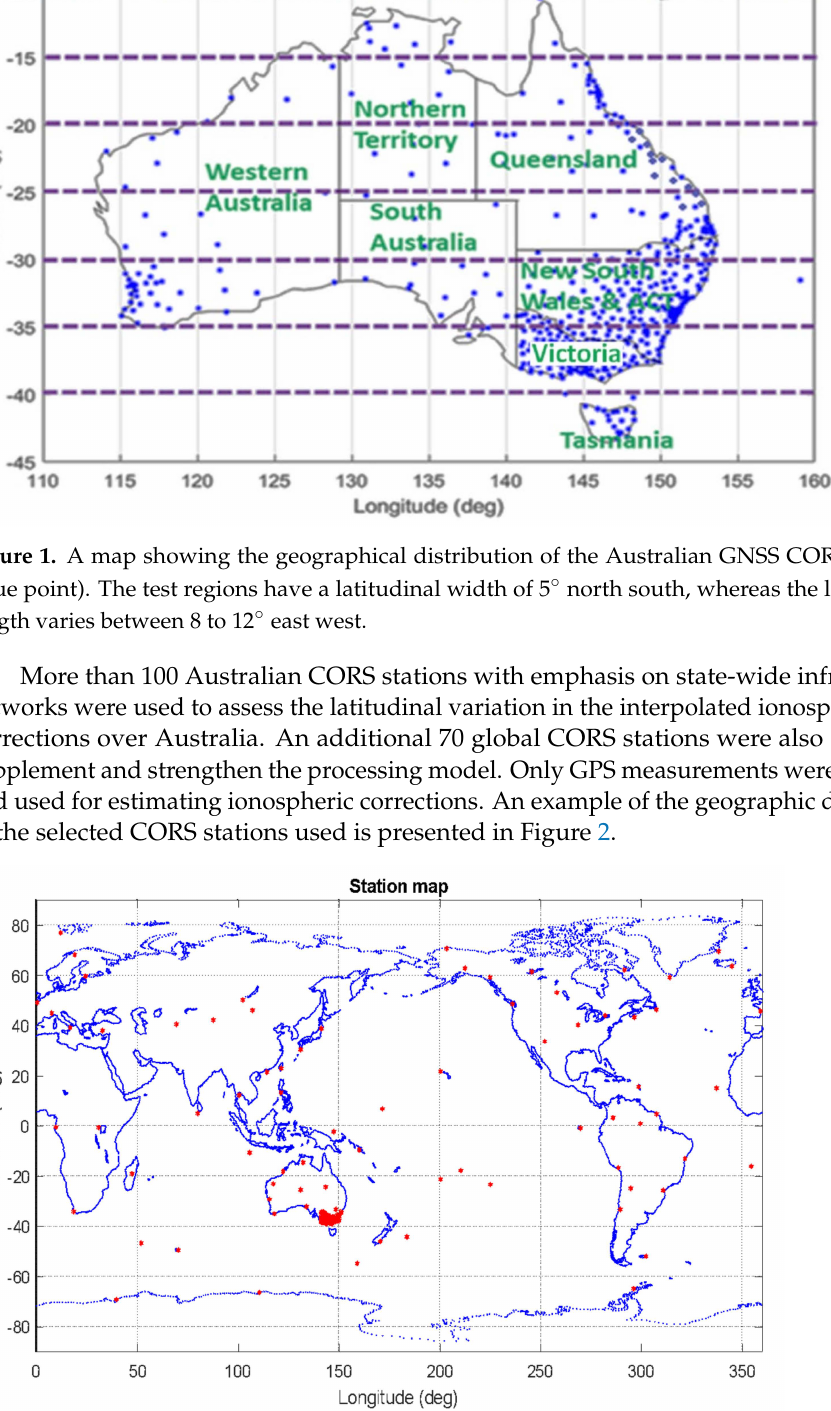
Figure 2. A map showing the geographical distribution of the GNSS stations (red aasterisks) used to compute the ionospheric corrections for the Victoria region. Respective statewide CORS stations in New South Wales (NSW), Australian Capital Territory (ACT), Western Australia (WA), North Territory (NT), Queensland (QLD) and South Australia (SA) were used to derive ionospheric corrections for those